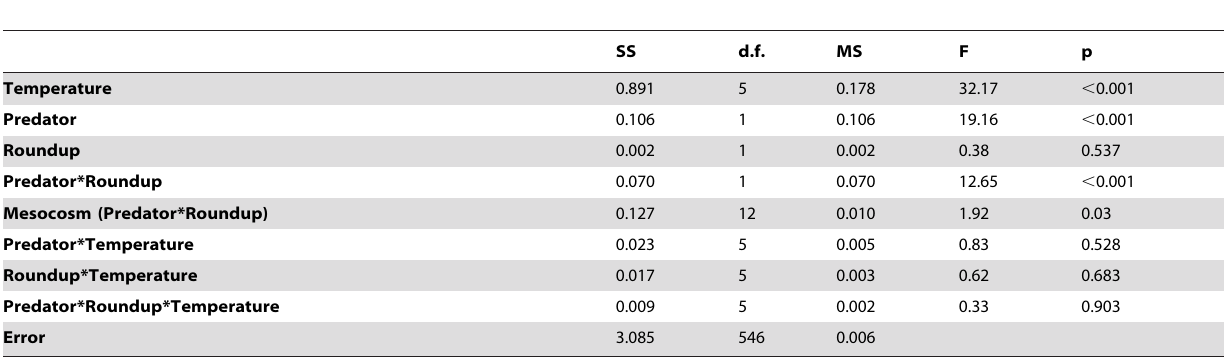
Table 5. ANOVA using burst speed as dependent variable, and temperature, mesocosm, predator cues and Roundup as categorical predictors, with mesocosm nested within the interaction of predator cues and Roundup, for Hyla versicolor .